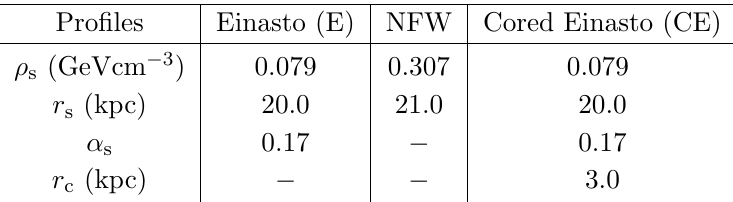
Table 1. Parameters of the Einasto, NFW and Cored Einasto DM pro(cid:12)les at the GC considered in this